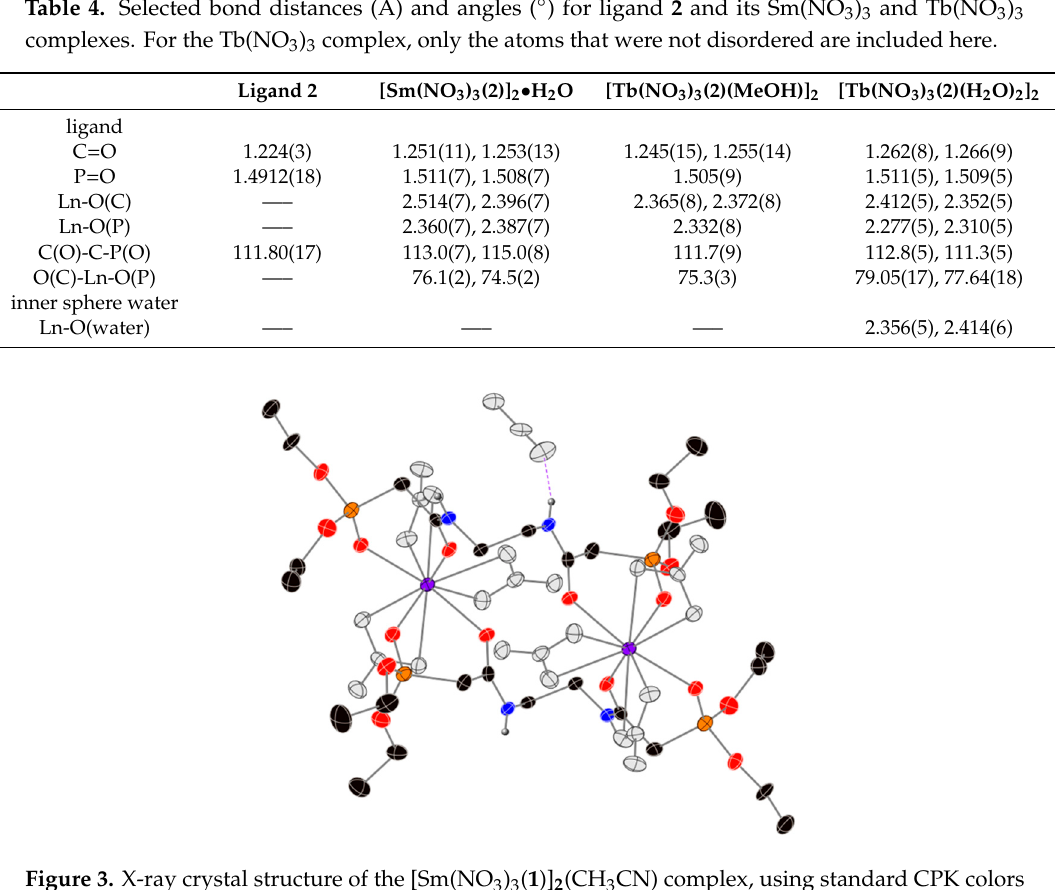
Figure 3. X-ray crystal structure of the [Sm(NO 3 ) 3 ( 1 )] 2 (CH 3 CN) complex, using standard CPK colors for the atoms of ligand 1 (Sm 3+ = purple spheres). The atoms of the nitrate groups and solvent acetonitrile are depicted as grey spheres to make it easier to visualize the structure of the ligands and the metal’s coordination geometry. Thermal ellipsoids are drawn at the 40% probability level, only hydrogen atoms bonded to nitrogen atoms are shown for clarity, and the hydrogen bonding interaction is depicted with a purple, dashed line. Only the major component is shown for clarity. The Tb 3+ complex is isomorphic to this structure, and shown in the Supplementary Materials.